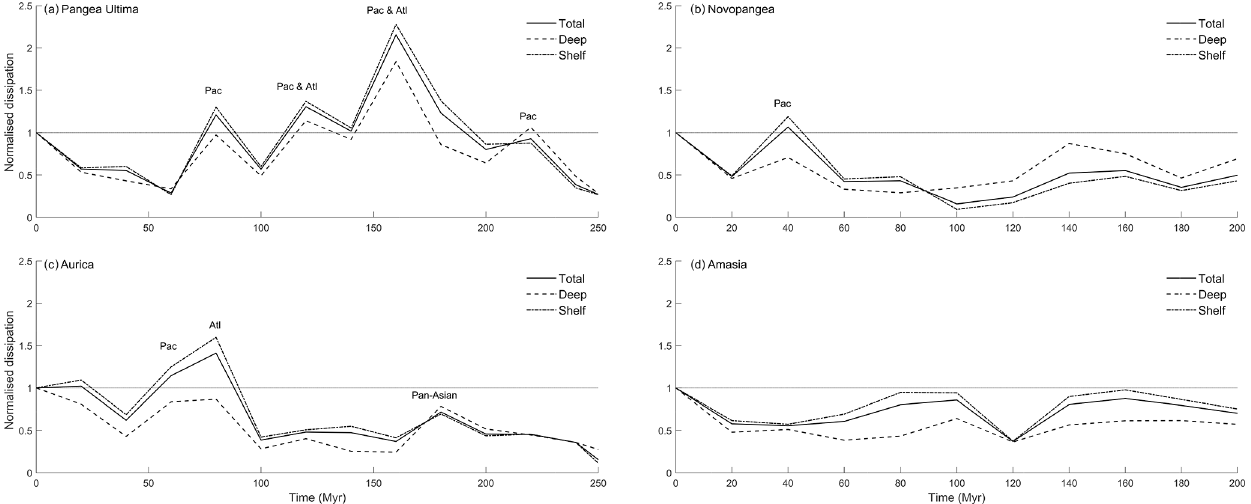
Figure 3. Normalized (against PD degenerate) globally integrated dissipation rates for the Pangaea Ultima (a) , Novopangaea (b) , Aurica (c) , and Amasia (d) scenarios. The lines refer to total (solid line), deep (dashed line), and shelf (dotted–dashed line) integrated dissipation values. Each super-tidal peak is marked where it reaches its peak. Pac stands for Pacific and Atl stands for Atlantic.